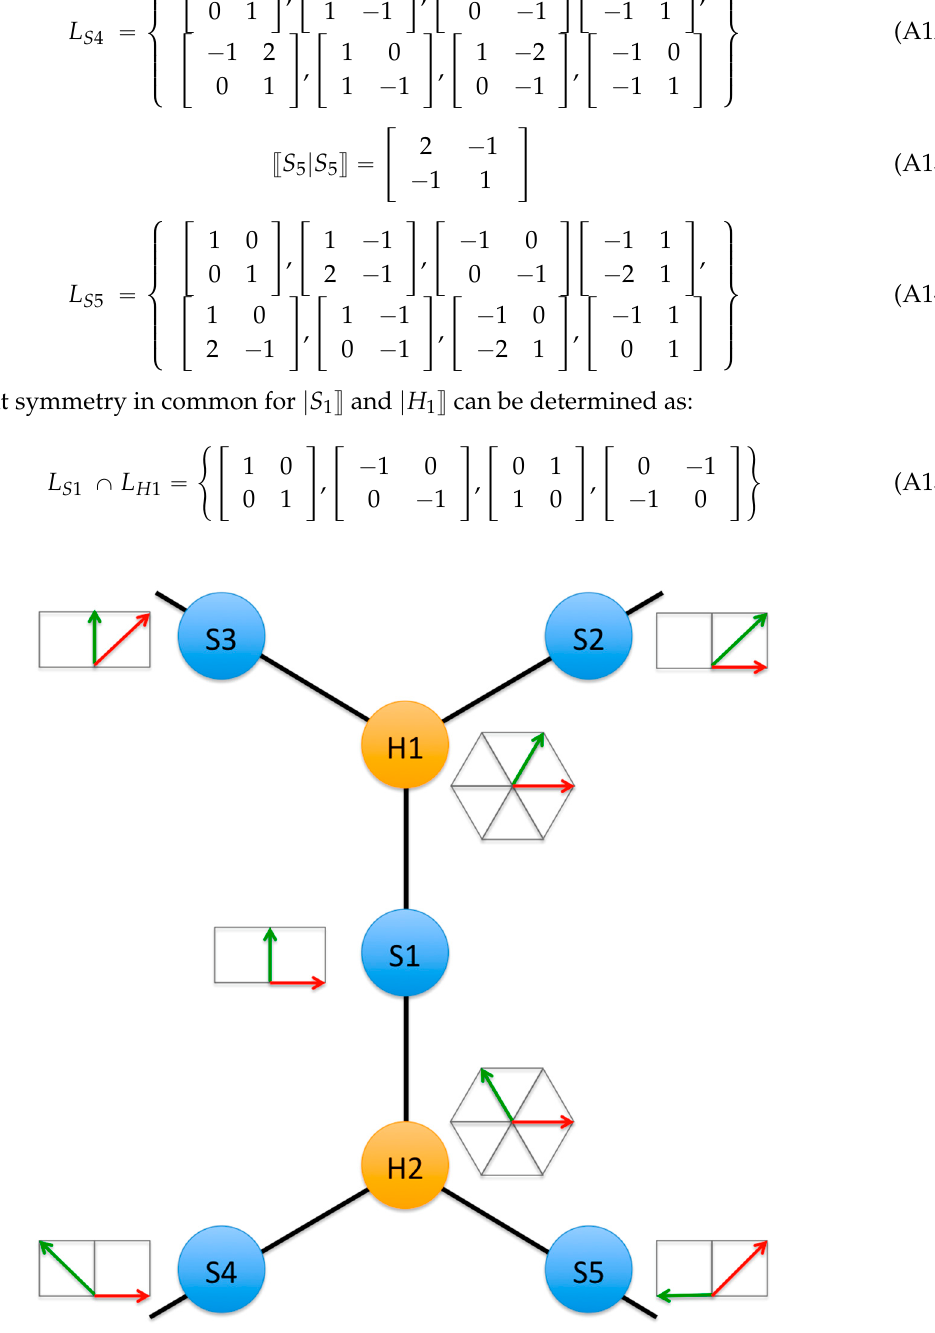
Figure A1. Phase transition graph for the square to hexagonal transformation in two dimensions (2D). The red and green arrows in each state describe two independent vectors in a 2D lattice. They also indicate the lattice correspondence among all of the structural states.